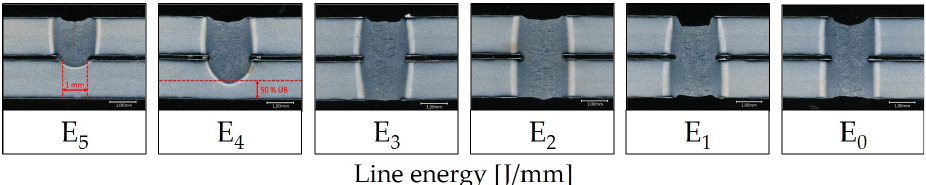
Figure 9. Difference in depth penetration for steel A depending on line energy in cross-sections of lubricated samples.